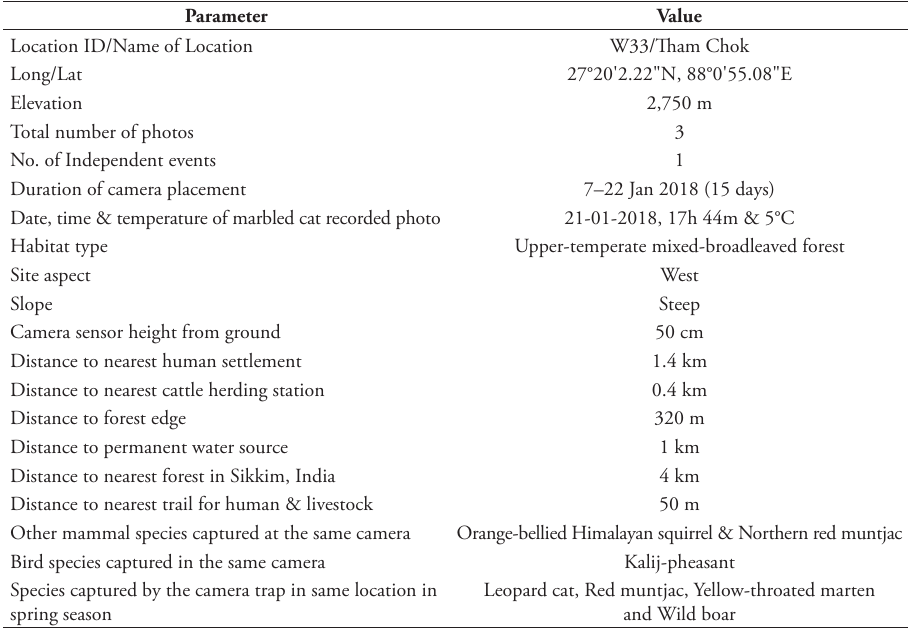
Table 1. Camera trap location details where the marbled cat was photographed in Southern Kangchen- junga region, eastern